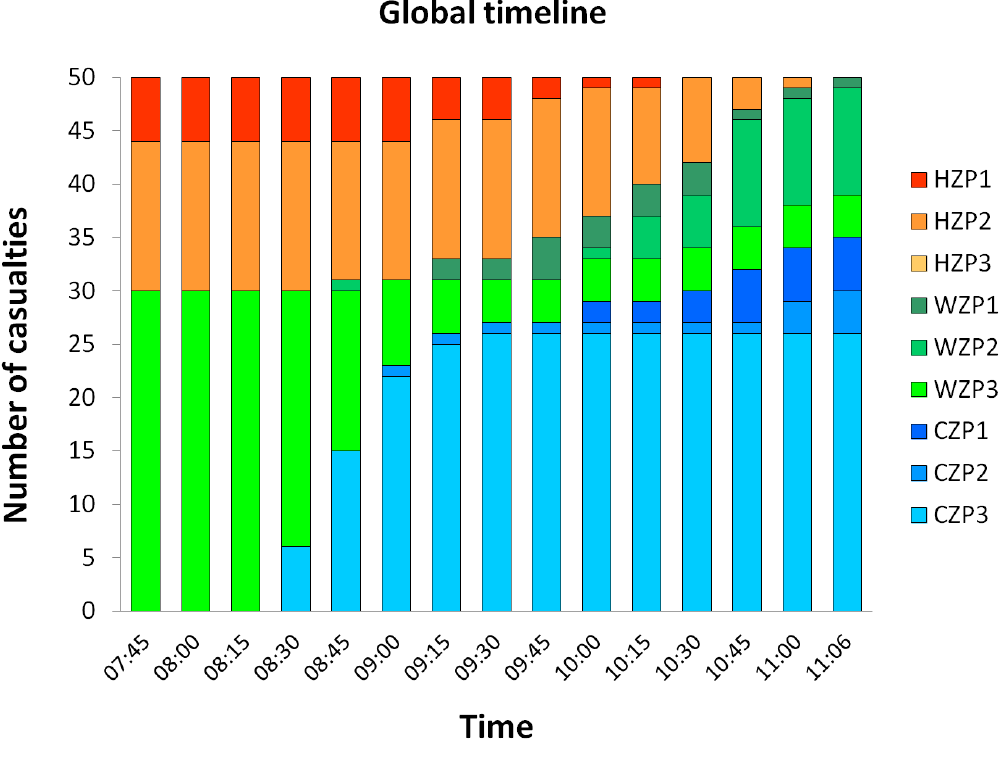
Figure A3. This graph represents the same information as in Figure A2 but with the data stratified by severity of injury ( i.e. , P1, P2, and P3). Due to the first 45 minutes ―notional play‖ there were no P3 casualties in the hot zone at the beginning of the exercise. The first P2 casualty entered the cold zone after 1 hour (having walked unaided from the hot zone to the warm zone) and the first P1 casualty entered the cold zone after 2 hours. The final P1 casualty was removed from the hot zone after 2 hours 30 minutes and the final P2 casualty was removed from the hot zone after 3 hours 15 minutes. The four P3 casualties that were still in the warm zone at the end of the exercise were those with non-waterproof electronic prosthetic